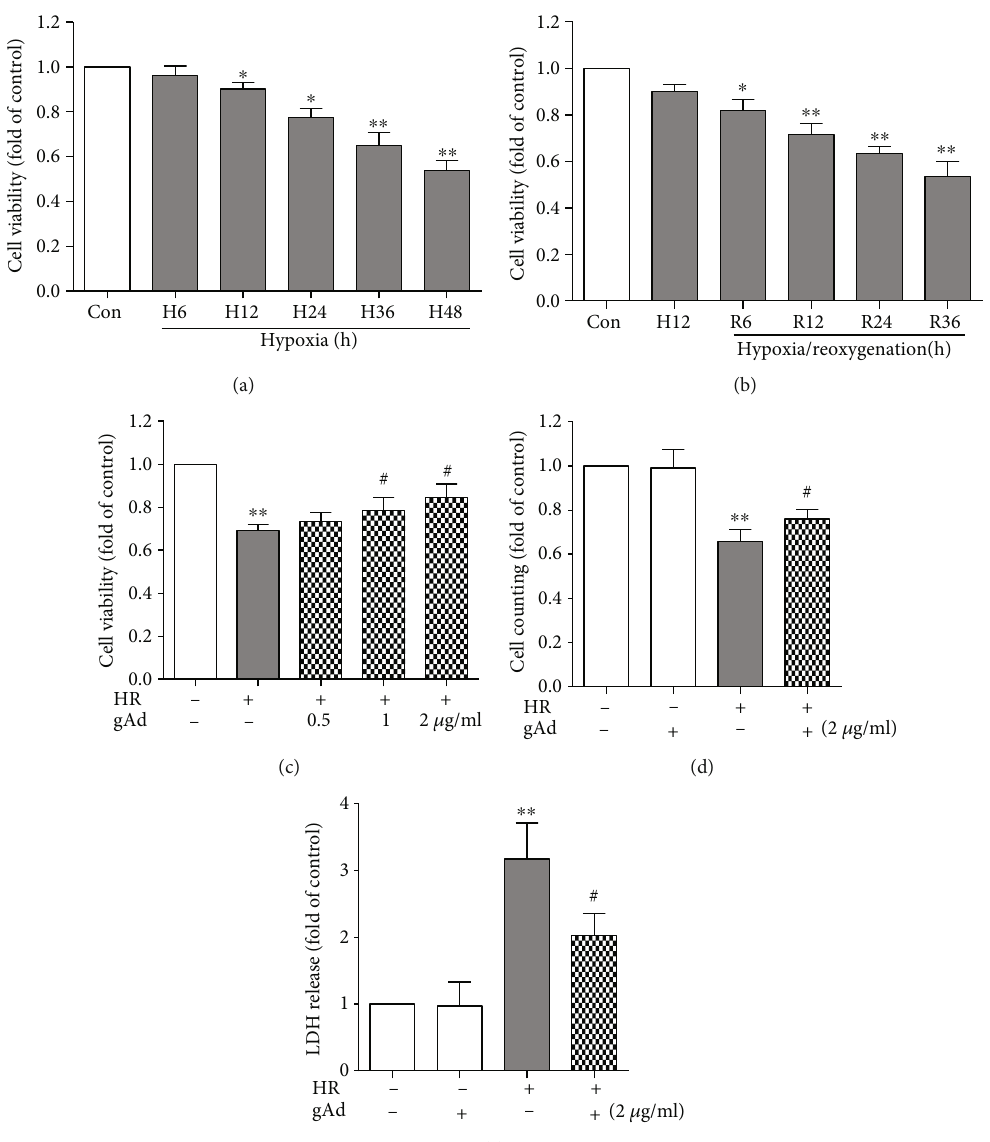
Figure 1: Globular adiponectin (gAd) improved cell viability during hypoxia/reoxygenation. (a) Various time points of hypoxia (0, 6, 12, 24, 36, and 48 h) reduced the NRVM viability as demonstrated by MTT assay ( n = 5 ). (b) After 12 h of hypoxia and various reoxygenation periods (0, 6, 12, 24, and 36), the cell viability was signi fi cantly reduced compared with that of the control group ( n = 5 ). (c) The cell viability signi fi cantly increased following pretreatment of the cardiomyocytes with various concentrations of gAd (0, 0.5, 1, and 2 μ g/ml) ( n = 5 ). (d) The 2 μ g/ml dose of gAd increased the number of NRVM cells remaining after hypoxia/reoxygenation ( n = 5 ). (e) The 2 μ g/ml dose of gAd reduced the release of LDH in the culture medium compared with the HR model group ( n = 5 ). ∗ P < 0 : 05 and ∗∗ P < 0 : 01 vs. the control group; # P < 0 : 05 and ## P < 0 : 01 vs. the H12/R12